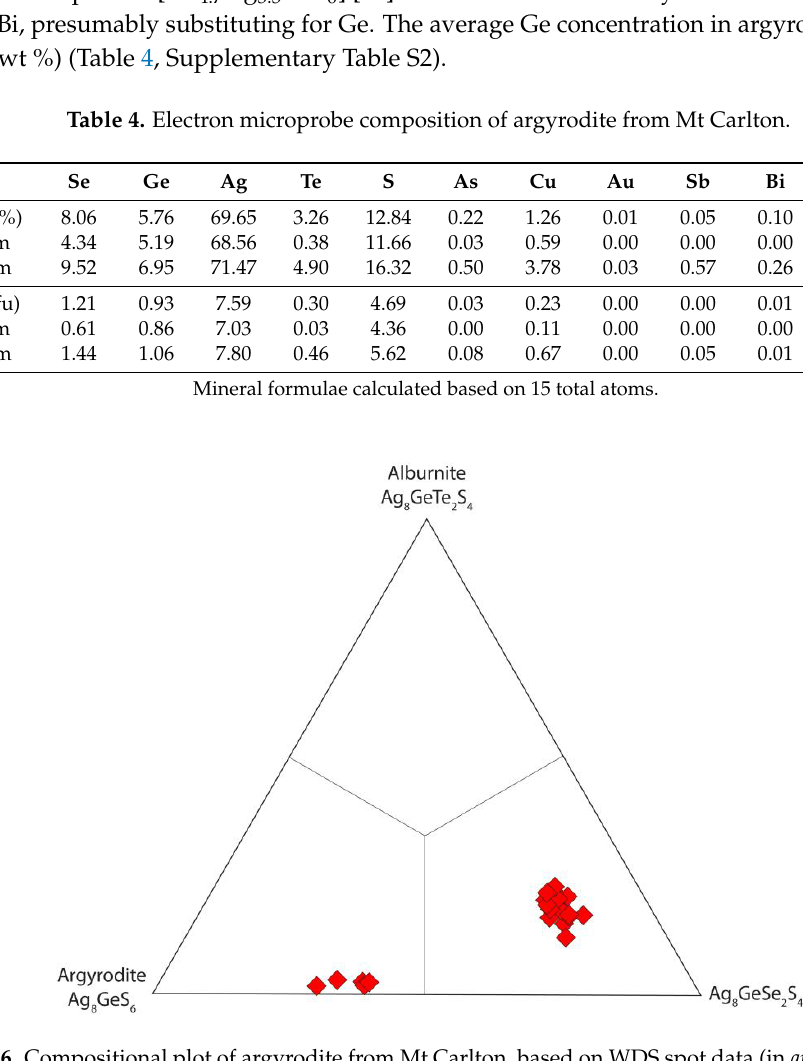
Figure 6. Compositional plot of argyrodite from Mt Carlton, based on WDS spot data (in apfu ). The two clusters represent analyses of two individual grains.